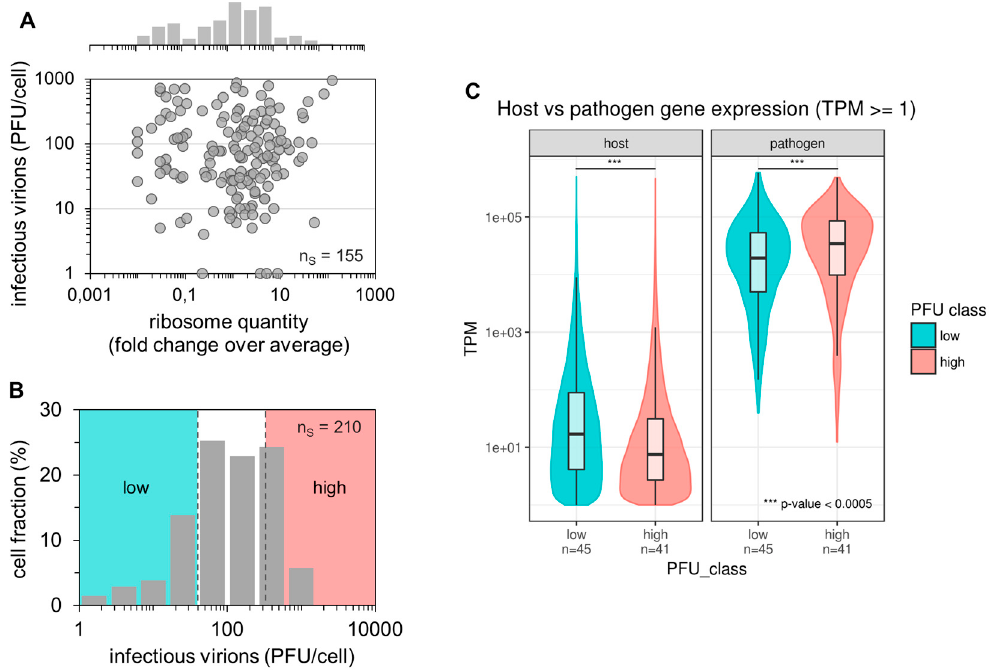
Figure 3. Impact of ribosome quantity, fraction of viral and host cell mRNAs on single-cell virus yield. Single PR8-infected MDCK cells (MOI = 10) were incubated until 12 hpi (as shown in Figure 1). Afterward, virus yields were investigated using the plaque assay, intracellular 18S rRNA via real-time RT-qPCR, or intracellular host cell and viral mRNA via scRNA-seq. n S indicates the number of single-cell measurements. ( A ) Dependency of single-cell virus yield on the ribosome content. The ribosome quantity was estimated based on the assumption that exactly one 18S rRNA molecule is associated with each ribosome. Next, the fold change over the average single-cell 18S rRNA expression was calculated. The pooled data of multiple independent experiments are shown ( n = 4). ( B ) Histogram of the single-cell virus yield of cells investigated by scRNA-seq (panel (C)). Colors indicate the lower and upper 22.86% of cells with respect to the virus yield (“low” and “high”, respectively). The pooled data of multiple independent experiments are depicted ( n = 3). ( C ) Host cell and viral mRNA content. Expression values (TPM ≥ 1) for host and viral genes are plotted on a log-scale for cells classified into low and high virus yields, as shown in Figure 3B. ***, p < 0.0005 by the Wilcoxon rank sum test.